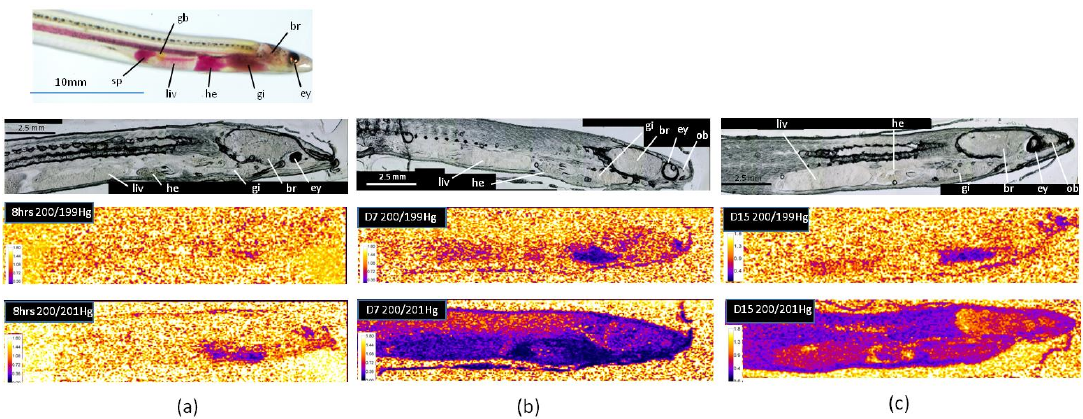
Figure 3. Isotope ratio images for ratio 200/201, referring to the presence of MeHg, and ratio 200/199, referring to the presence of Hg(II), after 8 h ( a ), 7 days ( b ), and 15 days ( c ) of the experiment (br: